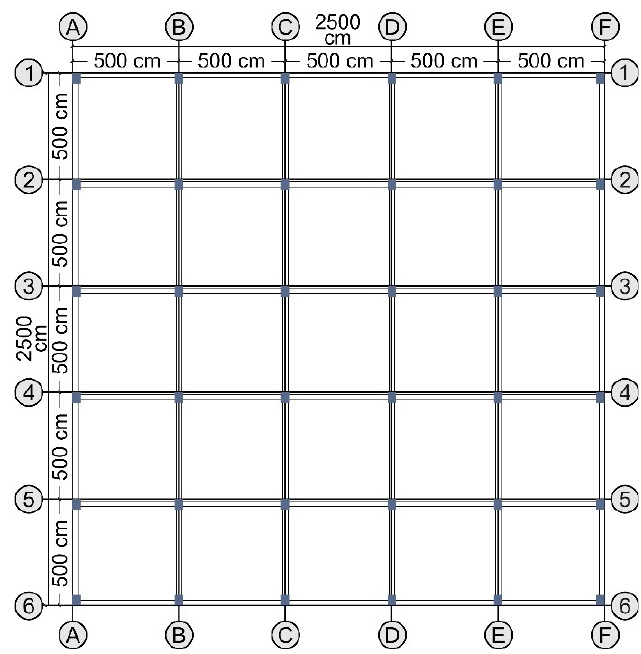
Figure 6. Material models for concrete and steel considered in the study [80].